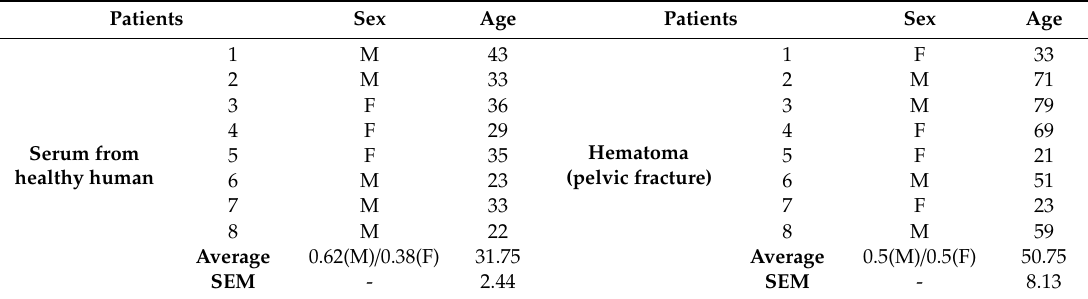
Table 1. Demographic information of